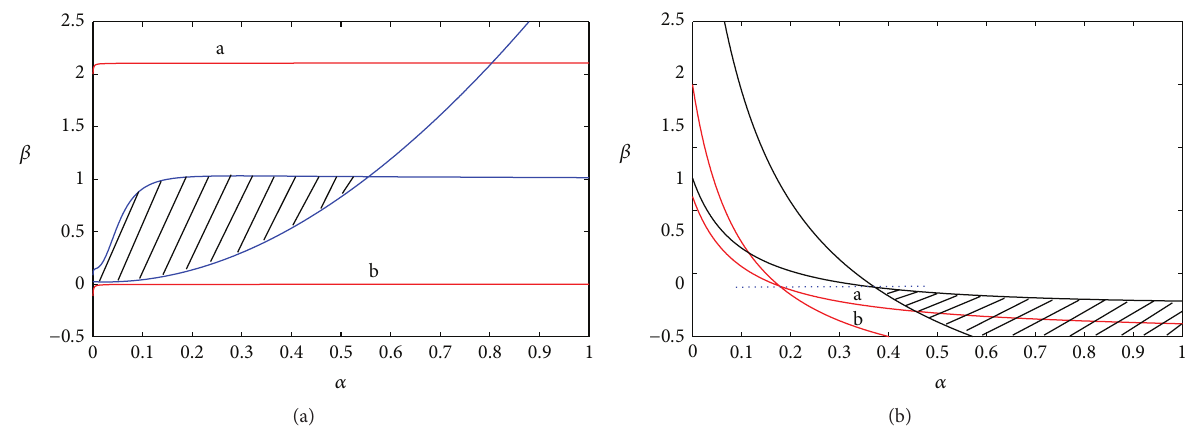
Figure 1: Compare the parameter regions of coexistence when the predator and prey are with Allee effect (shaded area) with those when they are without Allee effect, respectively. The area between lines a and b is the regions of coexistence when the predator-prey system is without Allee effect. (a) The situation of the predator with Allee effect. Parameter values are 𝑟 = 10 , 𝐾 = 100 , and 𝑢 1 = 6 ; (b) the situation of the prey with Allee effect. Parameter values are 𝑟 = 0.1 , 𝐾 = 100 , and 𝑢 2 = 6